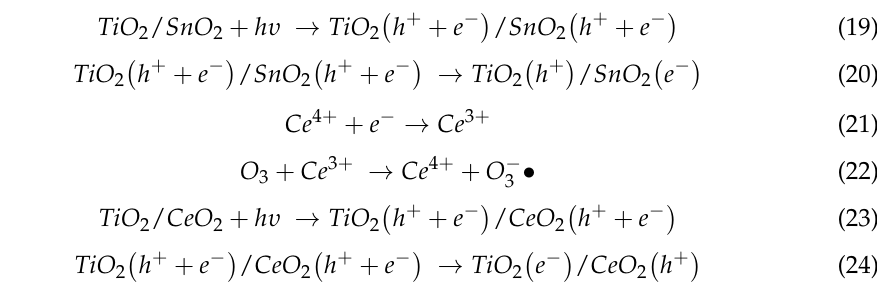
Figure S5: Evolution of paracetamol normalized concentration during the oxidation process for (Ti-Ce-Sn) system for two successive cycles at lower ozone concentrations and 2 number of slides; Figure S6: Evolution of normalized UV254 parameter during the oxidation process for (Ti) system for two successive cycles at lower ozone concentrations and 2 number of slides; Figure S7: Evolution of normalized UV254 parameter during the oxidation process for (Ti-Ce) system for two successive cycles at lower ozone concentrations and 2 number of slides; Figure S8: Evolution of normalized UV254 parameter during the oxidation process for (Ti-Ce) system for two successive cycles at lower ozone concentrations and 2 number of slides; Figure S9: Evolution of normalized UV254 parameter during the oxidation process for (Ti-Ce) system for two successive cycles at lower ozone concentrations and 2 number of